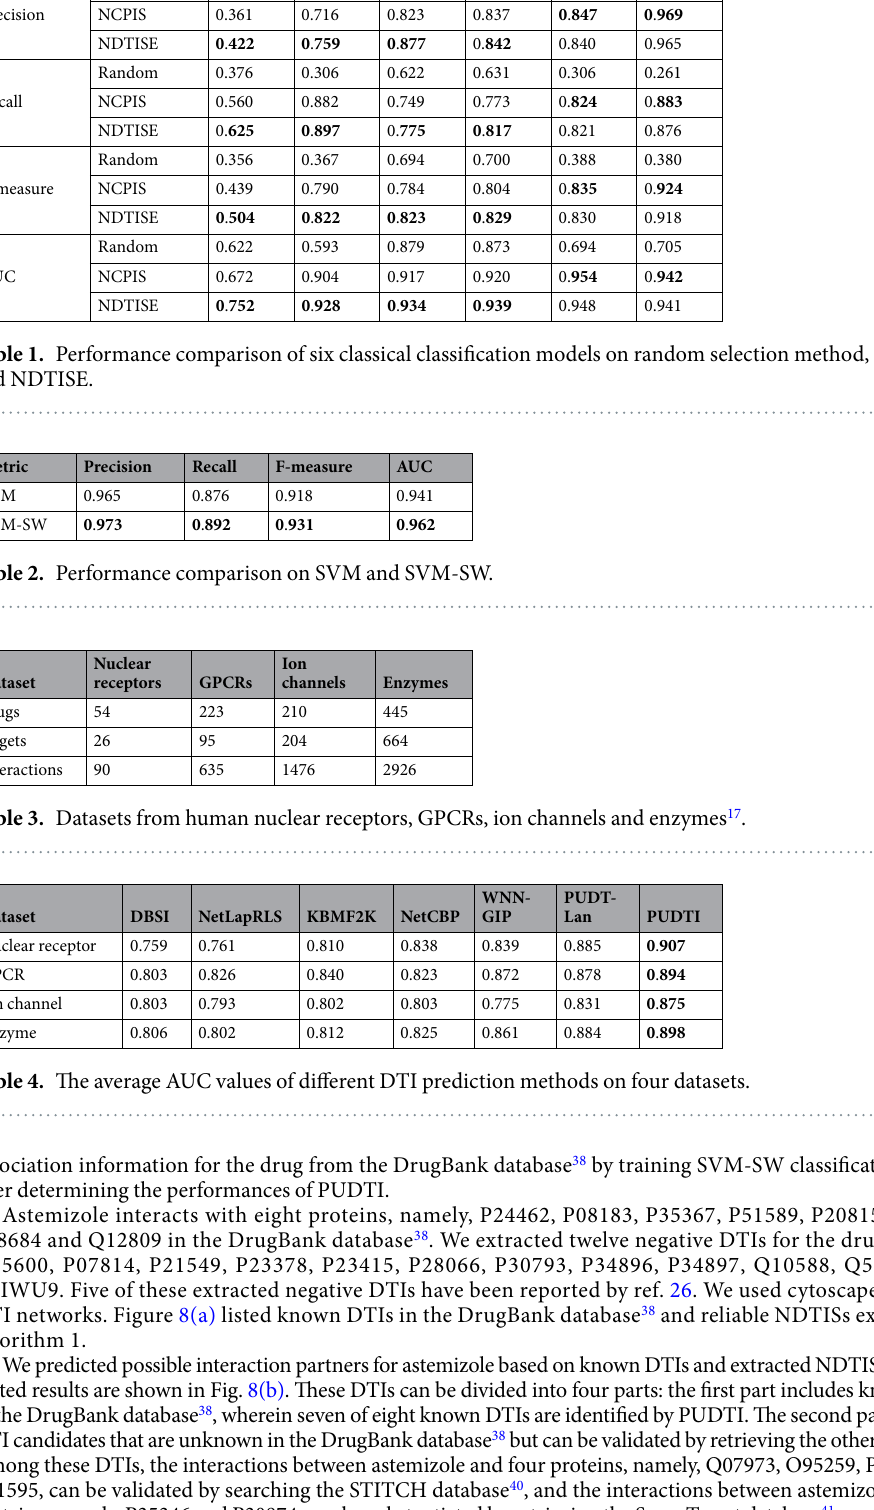
algorithm 1. We predicted possible interaction partners for astemizole based on known DTIs and extracted NDTISs. The pre-